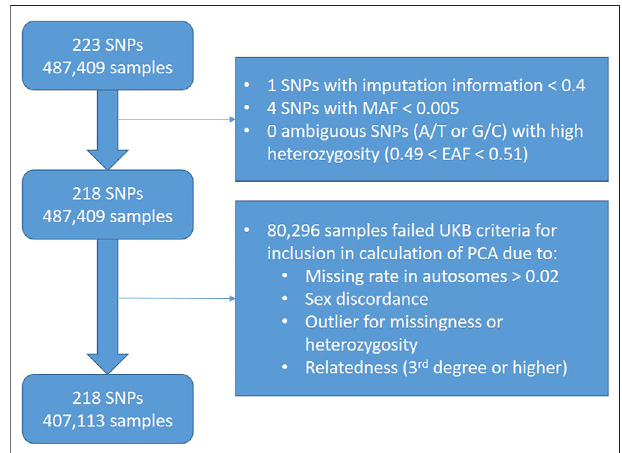
FIGURE 3 | Flowchart showing quality control exclusions in worked example of LDL-C PRS in UK Biobank